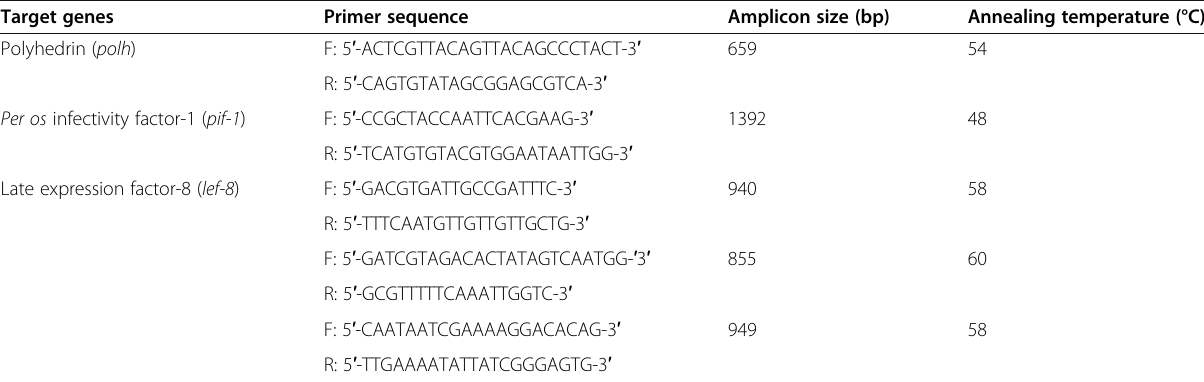
Table 1 Details of the baculovirus target core genes, primer sequences, and annealing temperature for amplification of DNA fragments